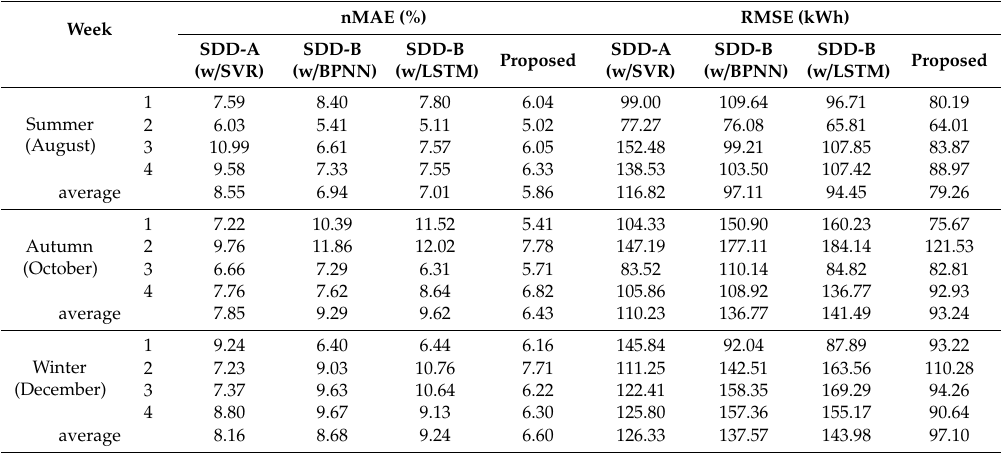
Table 5. Weekly nMAE and RMSE of PV power forecasting with di ff erent SDD